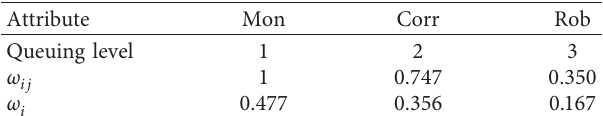
Figure 4: Residual curve of the full bearing life cycle. Table 2: Weight calculation of each attribute.